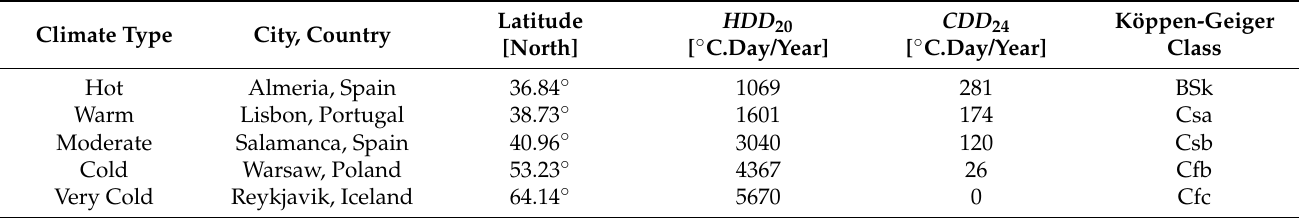
Table 1. Climatic data of the selected 5 cities with distinct climate